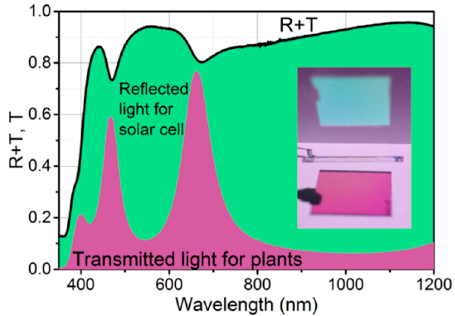
Figure 9. Reflection R and transmission T of the spectrally-selective reflector. Photons from the green area can be converted in the solar cell, while the violet area is transmitted to the plants. The white area marks the parasitic absorption. The thickness of the silver layers is 15 nm, while the sandwiched aluminum-doped zinc oxide (AZO) thickness is 271 nm and the thickness of the outer AZO is 85 nm. The inset shows a photograph of the Metal–Oxide–Metal–Oxide (MOMO) reflector on glass under white light illumination with its spectrally selective reflection and transmission colors.